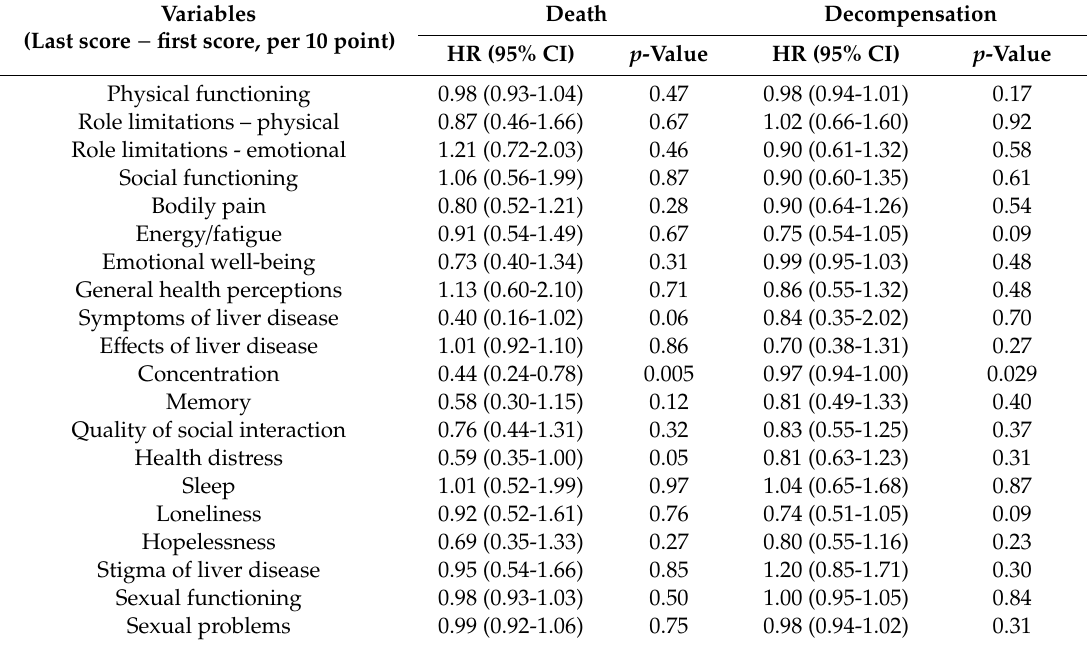
Table 5. Cox proportional hazards model of score changes of the LDQOL 1.0 components for death and